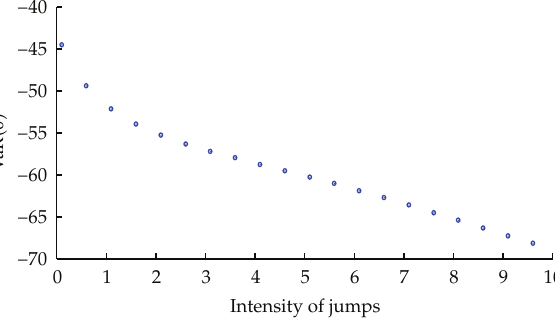
Figure 2: The impact of correlation coe ffi cients on VaR. Note that the symbols “ ◦ ”, “ ∗ ”, and “ the impact of correlation coe ffi cients, ρ 1 , 2 , ρ 2 , 3 , ρ 1 , 3 on absolute VaRs, respectively.